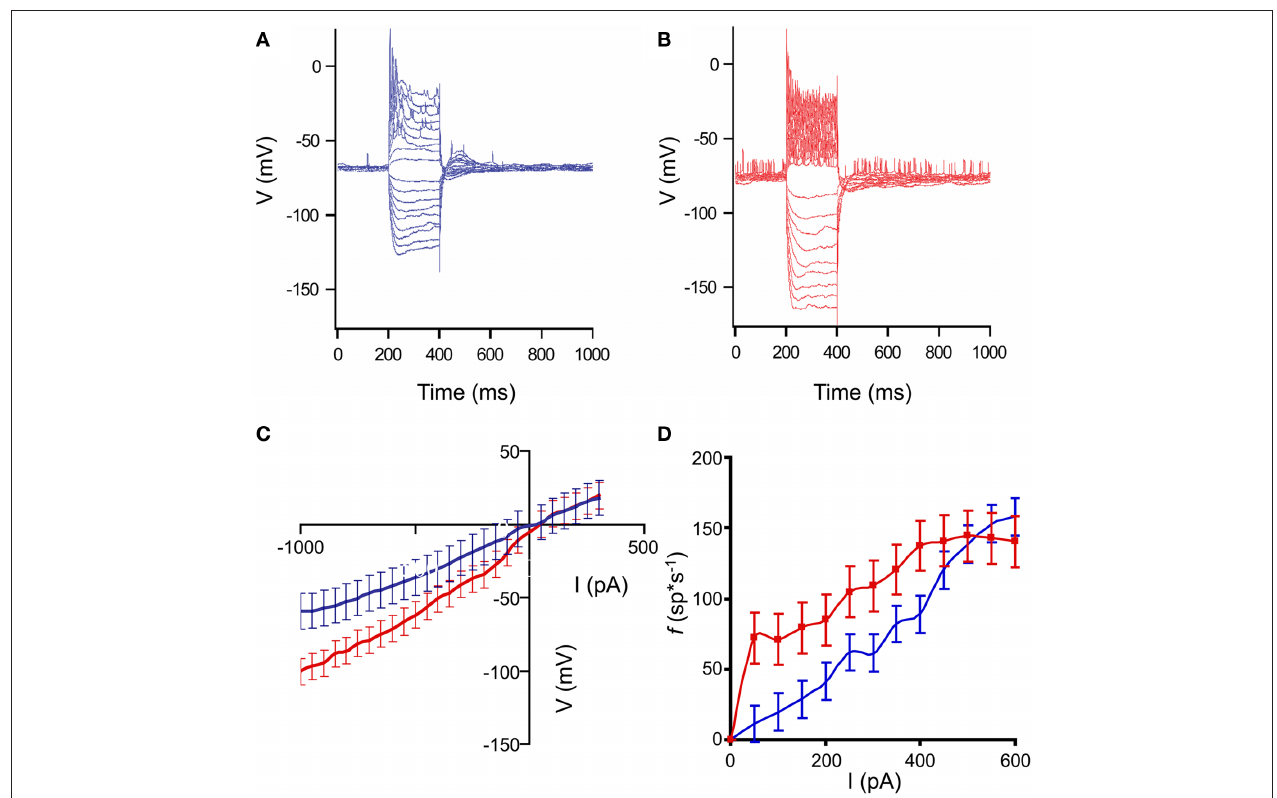
higher response frequency. (C) : Average current–voltage plots of control (blue) and HD (red) neurons. Error bars represent between-neuron SD. Note the increased slope of the HD I/V curve. (D) . Average excitation-to-frequency (f/I) plots for control (blue) and HD (red) neurons. Error bars represent between-neuron SD. The lines are smoothed between the measured points. Note the increase in the f/I slope in the lower part of the range, indicating that the HD neurons have smaller dynamic response ranges, and tend to respond abnormally to relatively